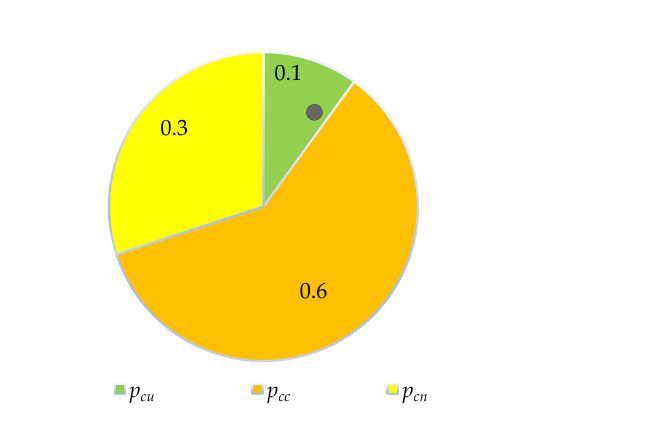
Figure 3. Example for roulette wheel selection: generated number (gray dot) falls on “plugged in but not